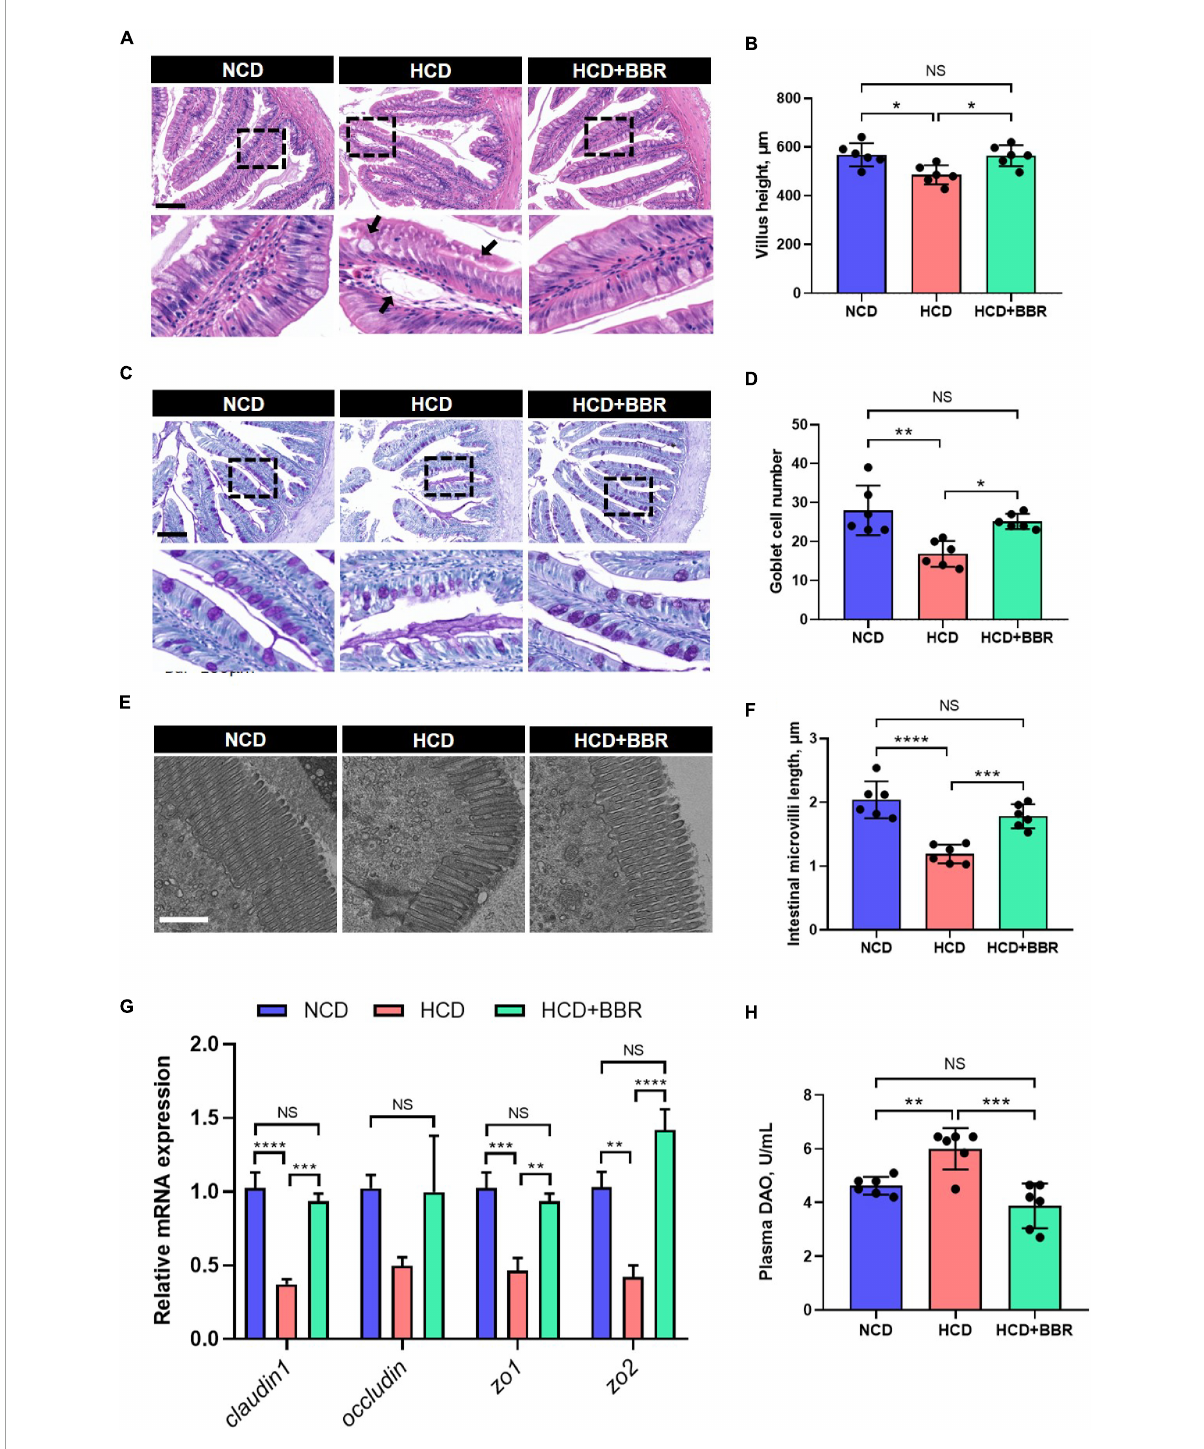
FIGURE2 Dietary BBR improved the HCD-induced morphology and barrier damages in the intestine of largemouth bass. (A) H&E staining images of intestinal sections (arrows indicate damages, bar = 100 µ m). (B) Villus height of intestine. (C) PAS staining images of intestinal sections (bar = 100 µ m). (D) Goblet cell number in villus. (E) Transmission electron microscope images of intestinal microvilli (bar = 1 µ m). (F) Intestinal microvilli length. (G) Expression level of tight junction-related genes. (H) Plasma DAO level. Data are represented as means ± SEM ( n = 6). *, **, ***, ****Different from each other: * P < 0.05, ** P < 0.01, *** P < 0.001, **** P < 0.0001, NS means no significant difference (One-way ANOVA, Duncan’s post hoc